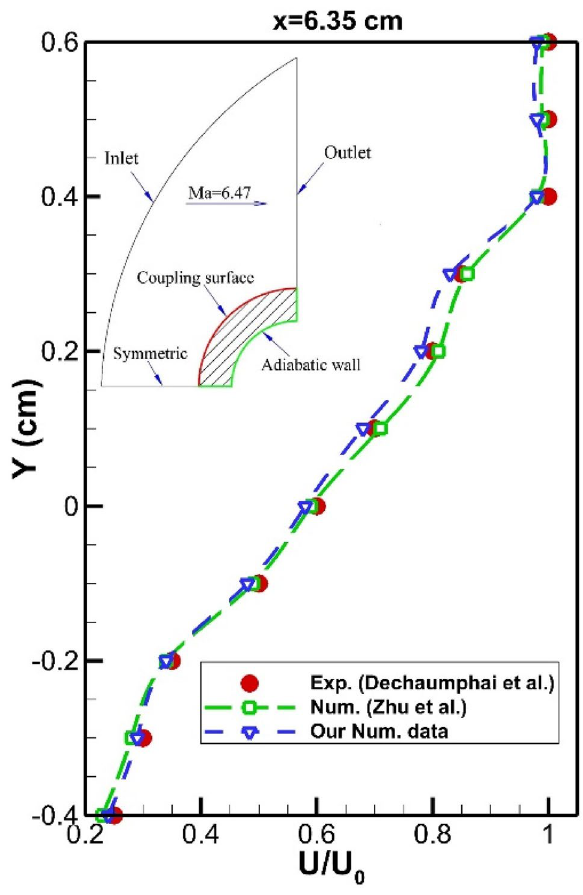
Figure 5. Validation of velocity profile velocity profile on the main nose